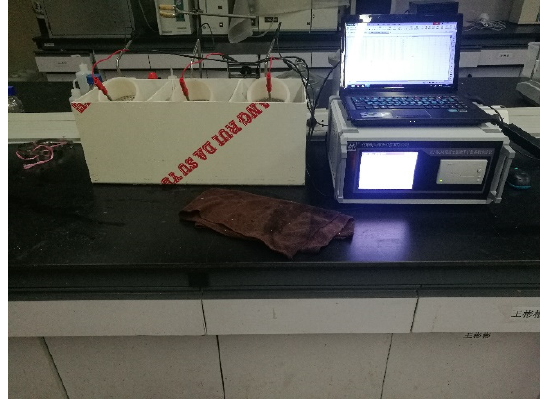
Figure 2. Rapid chloride analyzer (RCM). Table 5. Measured values of the chloride diffusion coefficients of cement-based materials.